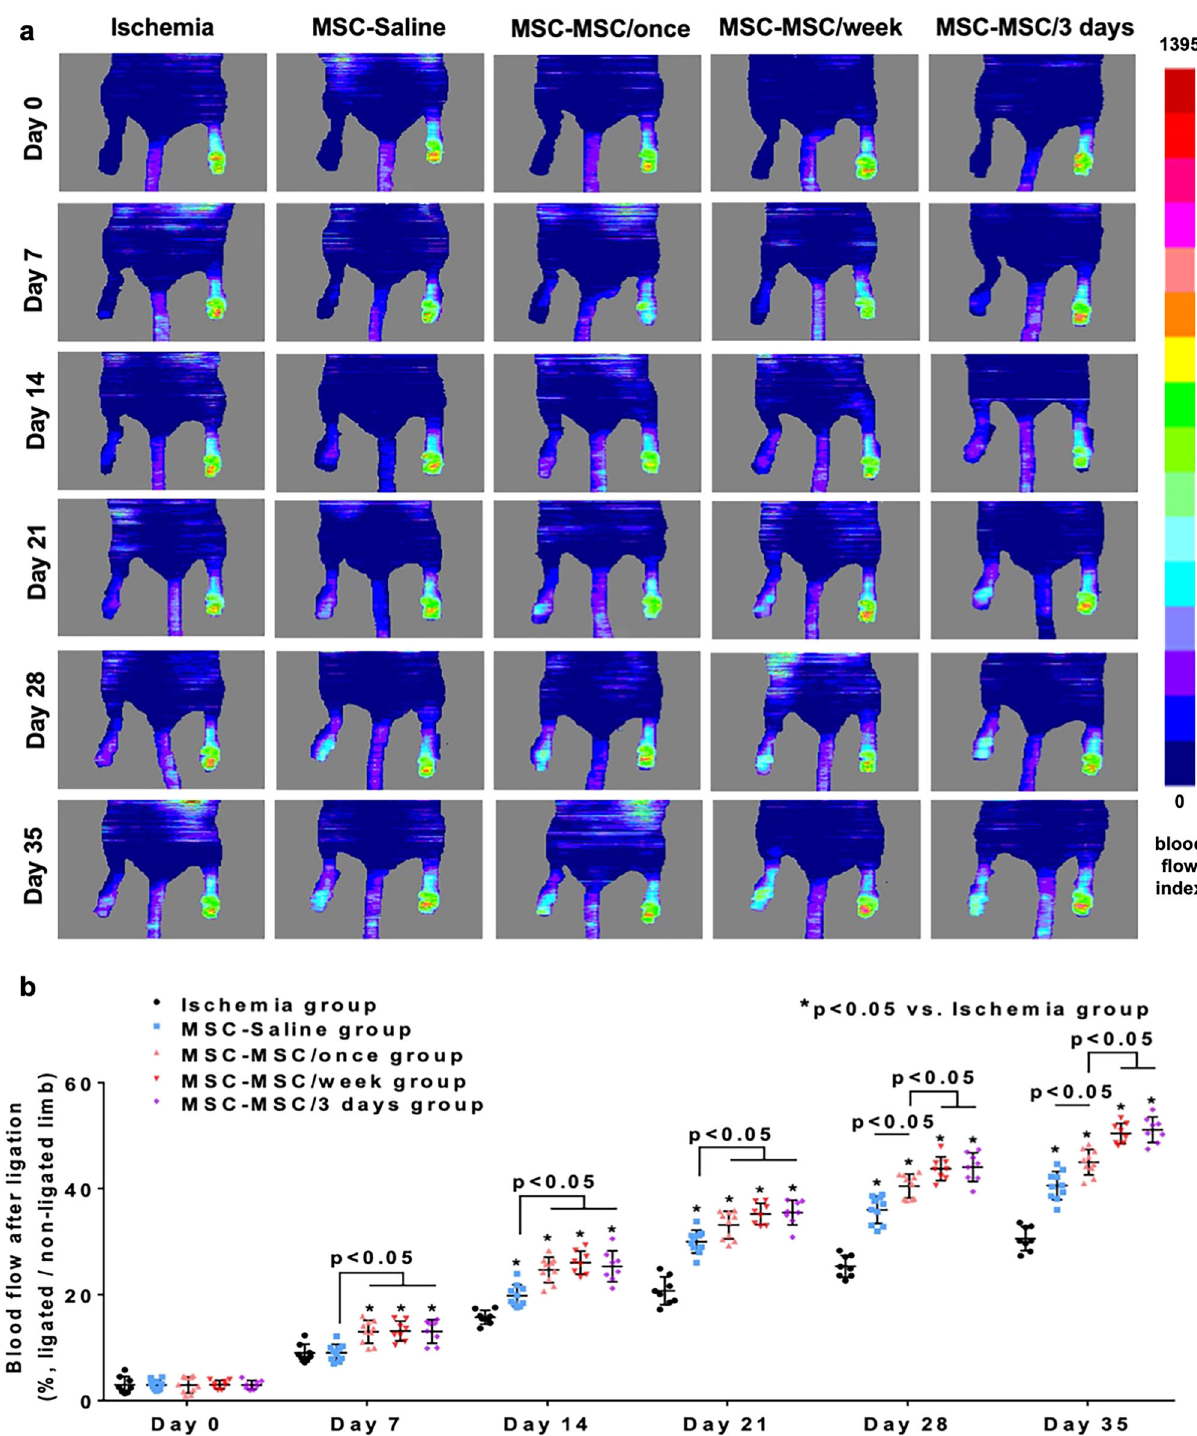
Fig. 3 Therapeutic ef fi cacy of intravenous cellular administration combined with intramuscular cellular delivery. Laser Doppler imaging analysis was performed immediately and every week following femoral artery ligation to evaluate blood perfusion in the ischemic hind limbs ( a ). After intramuscular transplantation of hiPSC-MSCs, blood perfusion was signi fi cantly improved in the MSC-Saline, MSC-MSC/once, MSC-MSC/week and MSC-MSC/3 days groups compared with the ischemia group from day 14 onwards (all p < 0.05). A single and repeated intravenous hiPSC-MSC infusion further improved blood perfusion in the MSC-MSC/once, MSC-MSC/week and MSC-MSC/3 days groups compared with MSC-Saline group (all p < 0.05). Moreover, the blood perfusion was signi fi cantly higher in the MSC-MSC/week and MSC-MSC/3 days groups compared with the MSC-MSC/once group (all p < 0.05). There was no signi fi cant difference between the MSC-MSC/week and MSC-MSC/3 days groups ( p > 0.05) ( b ).